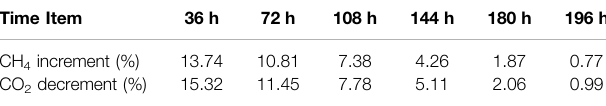
TABLE3| TheCH 4 incrementandCO 2 decrementingassamplescollectedevery 36 h in Experiment 3.